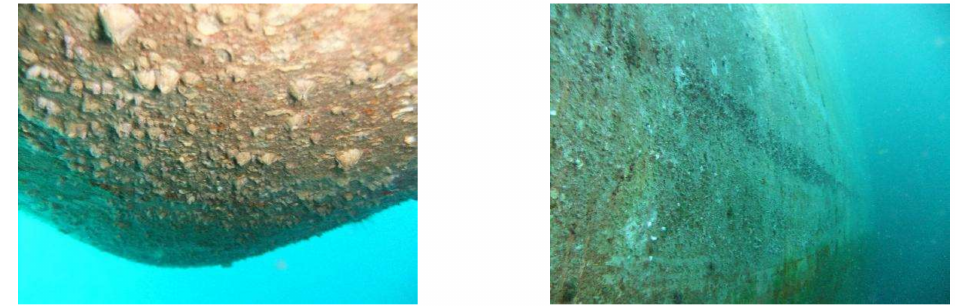
Figure 1. Marine fouling adhering to the ship hull